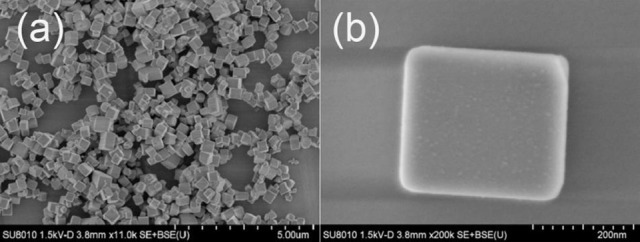
SEM images of the precursor TiOF2 at low (a) and high magnification (b).